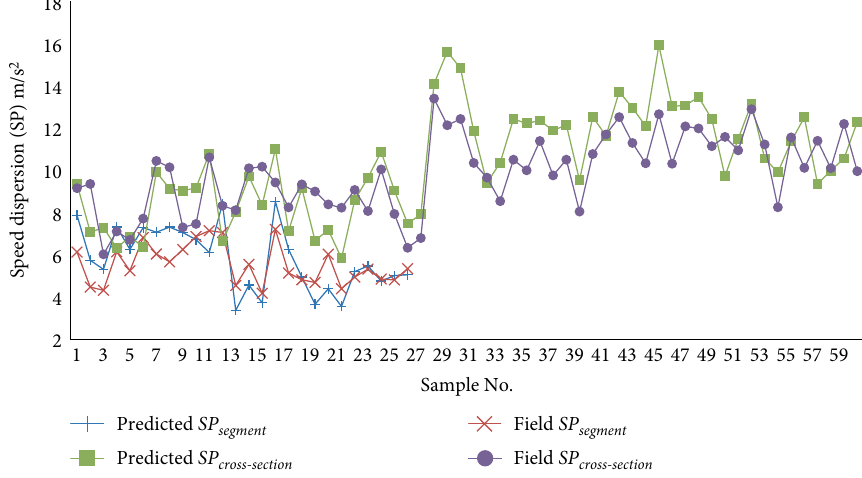
- and 𝑐𝑟𝑜𝑠𝑠 𝑠𝑒𝑐𝑡𝑖𝑜𝑛 𝑠𝑒 g 𝑚𝑒𝑛𝑡 𝑆𝑃 𝑆𝑃